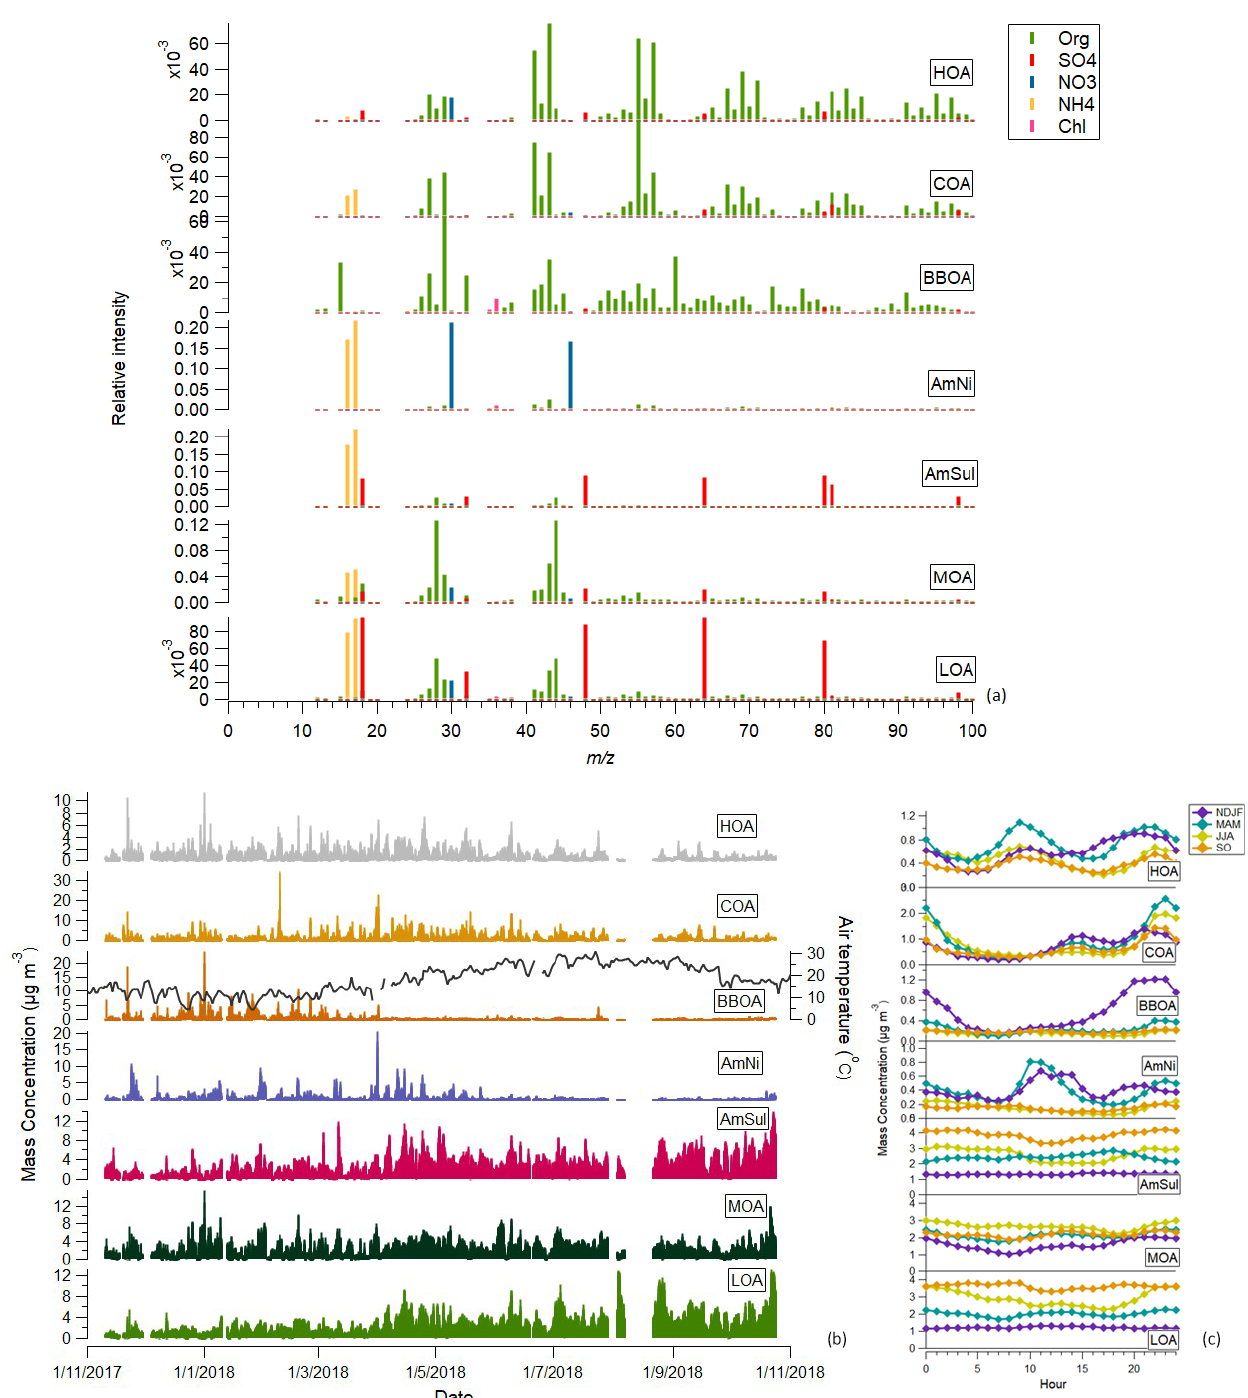
Figure 4. Mass spectra (a) , time series (b) and diurnal plots (c) of the seven submicron factors and (d) diurnal plot of AmNi with relative humidity and air